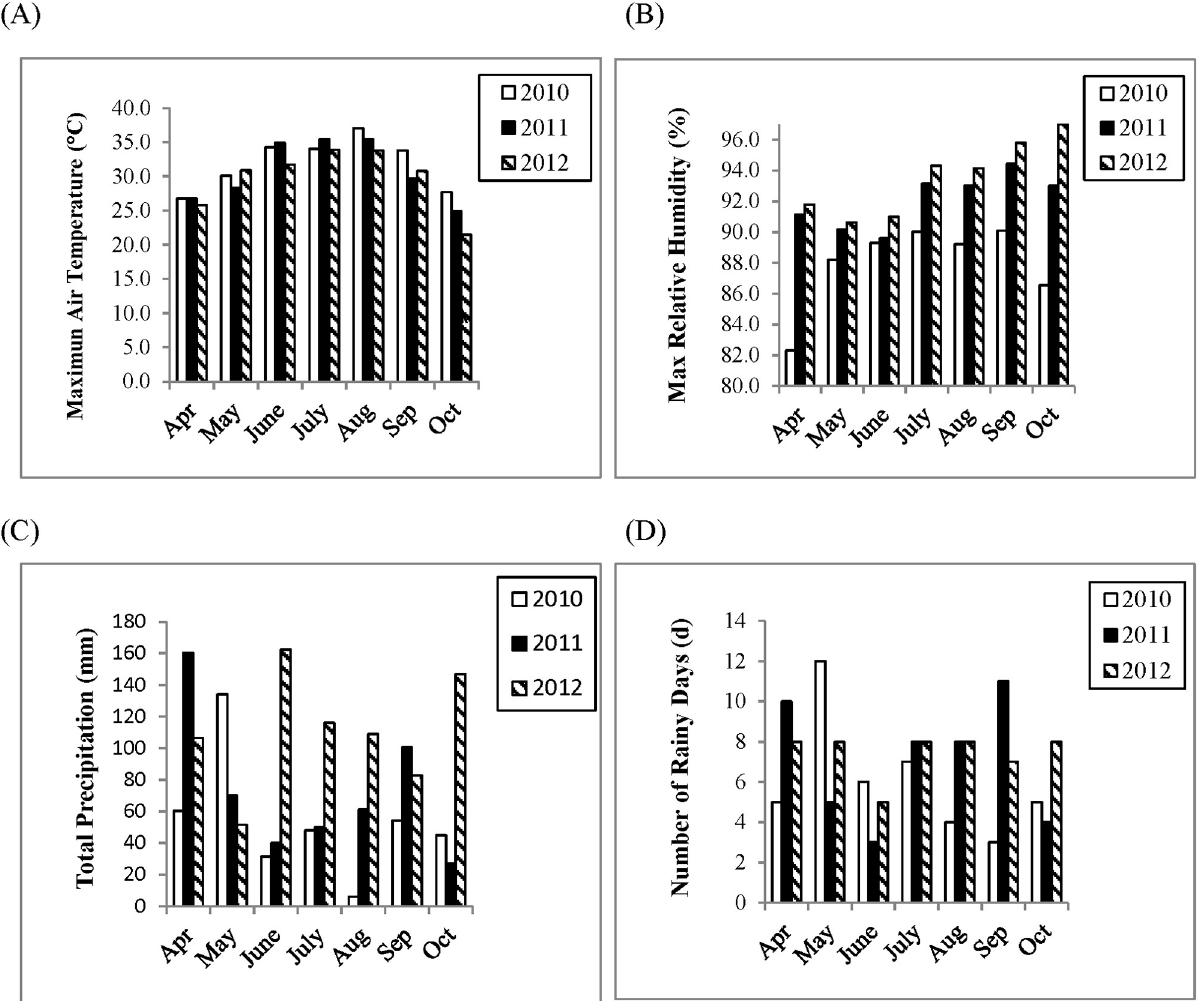
Fig 2. Weather information in Stoneville, MS during soybean growing seasons for the months of April through October in 2010, 2011, and 2012. A : Air maximum temperatures. B : Maximum relative humidity. C : Total precipitation. D : Number of rainy days.